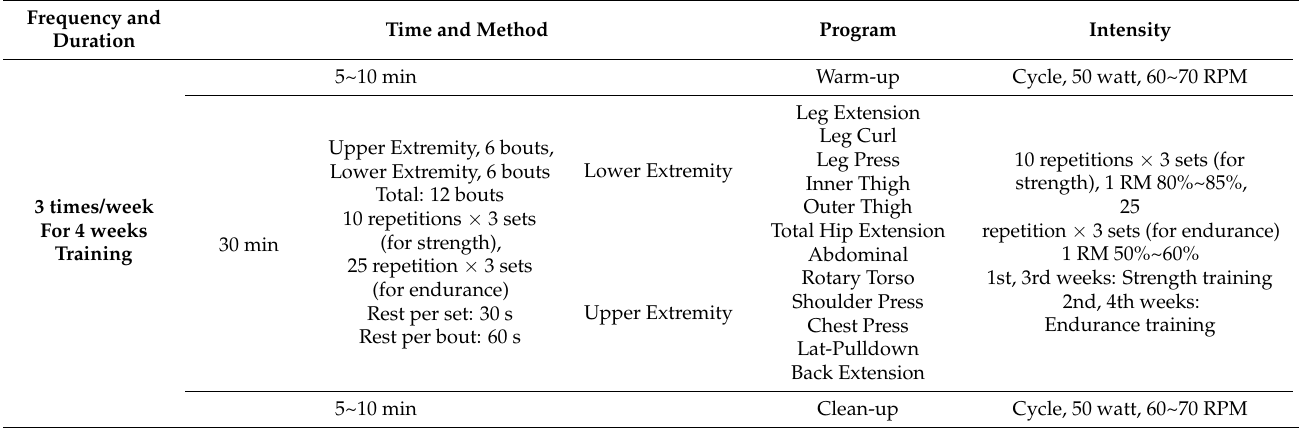
Table 2. Specific programs of Moderate Continuous Training (MCT).